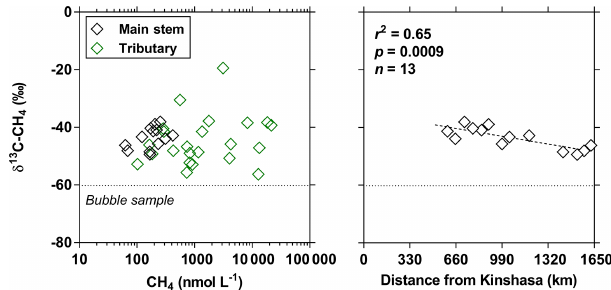
Figure 5. Carbon stable isotope composition of CH 4 ( δ 13 C-CH 4 in ‰) in surface waters of the Congo River main stem (black symbols) and tributaries (green symbols) as a function of dissolved CH 4 con- centration (nmolL − 1 ) and as a function of the distance upstream of Kinshasa, obtained along a longitudinal transect along the Congo River from Kisangani (10–30 June 2014). The dotted line indicates linear regression.